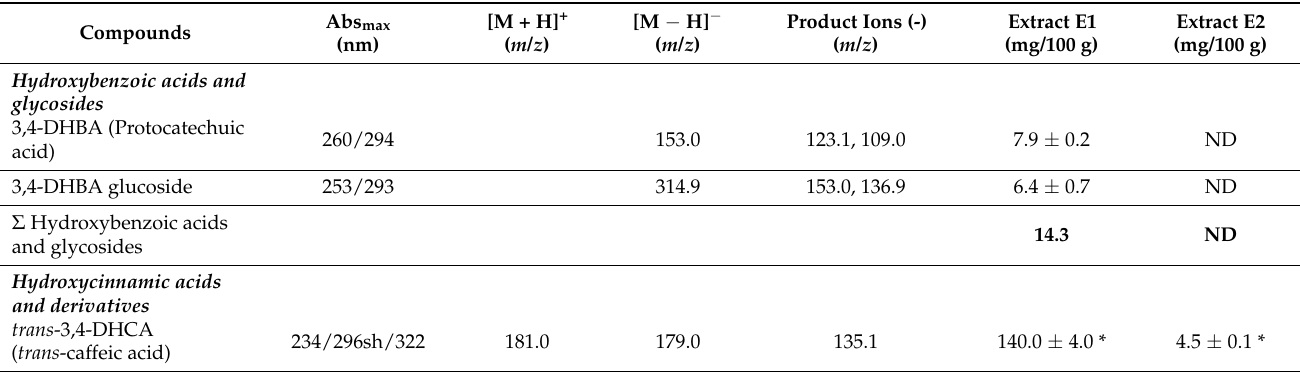
Table 1. Ultraviolet absorption, mass spectrometric data, and quantification of main phenolic and secoiridoid compounds present in olive-leaf extracts (E1 and E2). Quantification is expressed as mean value ± standard deviation on dry matter (mg/100